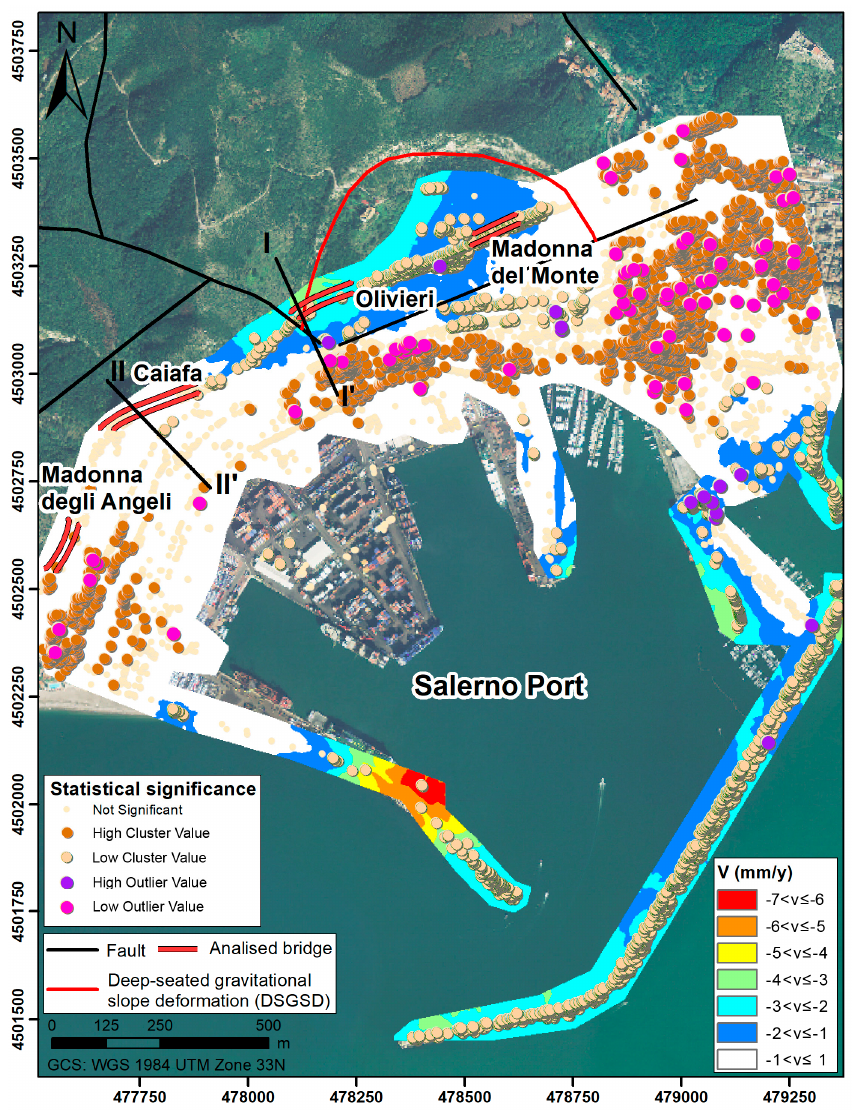
Figure 11. Interpolation of the velocities corresponding to the ground displacements obtained from the high-resolution sensor of the COSMO-SkyMed